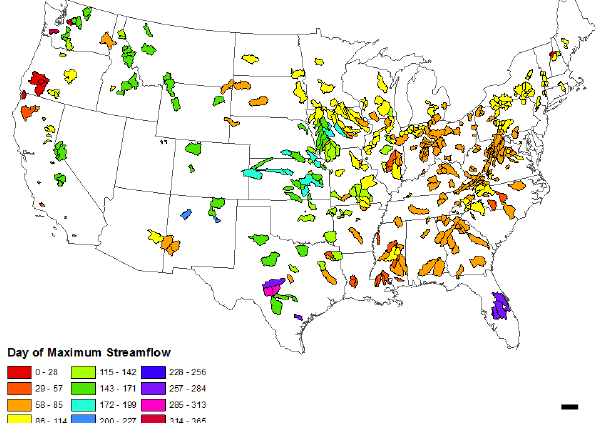
Fig. 5. Day of peak runoff